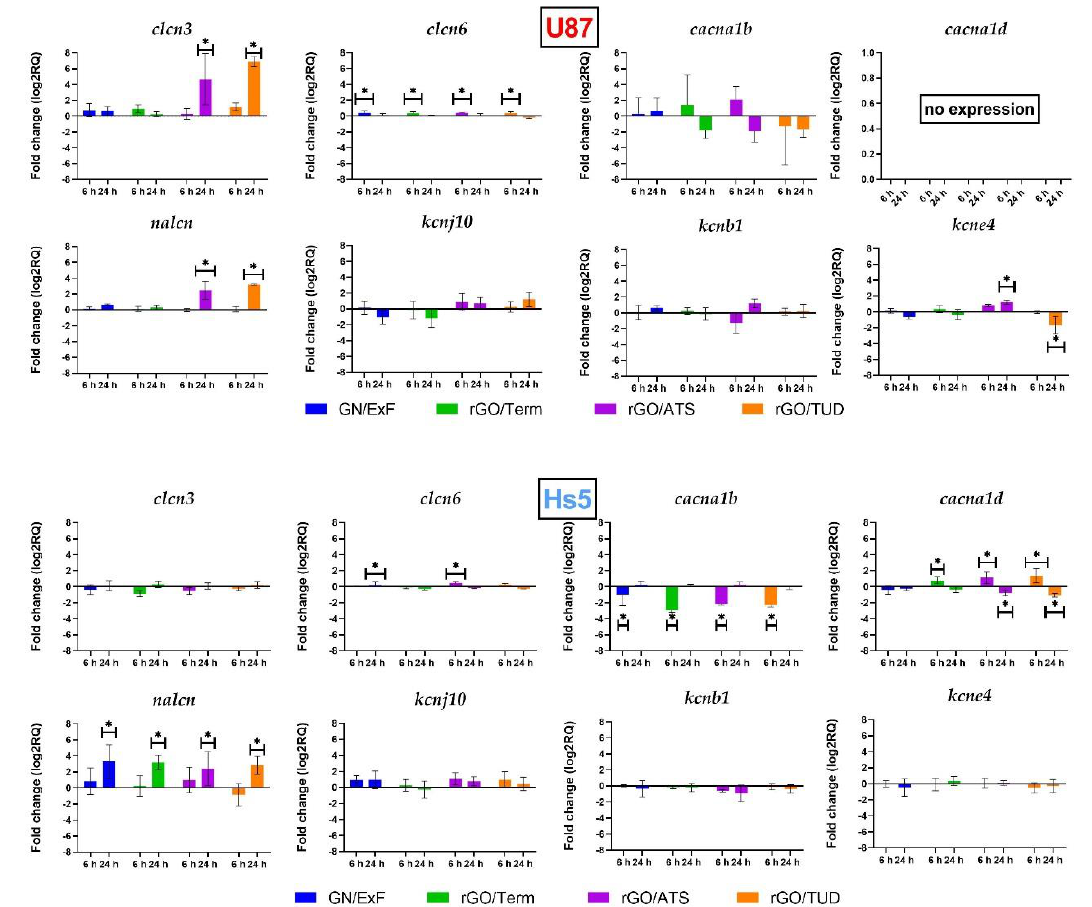
Figure 4. Analysis of the mRNA expression level of voltage-gated ion channels after treatment at 25 µg/mL concentration for 6 and 24 h in U87 and Hs5 cells. The results are calculated relative to the control values. Log2RQ (log2 relative quantitation) values for all genes are normalized to the RPL13A housekeeping gene. Statistical significance between the control and the treated cells is indicated by an asterisk and was assessed using Bonferroni’s multiple comparisons test. Differences with p -value <0.05 were considered significant. One asterisk ( * ) means p -value <0.05. Abbreviations : rGO, reduced graphene oxide; GN, graphene; C, control group (untreated group); ExF, exfoliation; Term, thermal; ATS, ammonium thiosulphate; TUD, thiourea dioxide; clcn3 , chloride voltage-gated channel 3; clcn6 , chloride voltage-gated channel 6; cacna1b , calcium voltage-gated channel subunit alpha1 B; cacna1d , calcium voltage-gated channel subunit alpha1 D; nalcn , sodium leak channel, non-selective; kcnj10 , potassium inwardly rectifying channel subfamily J member 10; kcnb1 , potassium voltage-gated Channel subfamily B member 1; kcne4 , potassium voltage-gated channel subfamily E regulatory subunit 4; rpl13a, ribosomal protein L13a; log2RQ, log2 relative quantitation